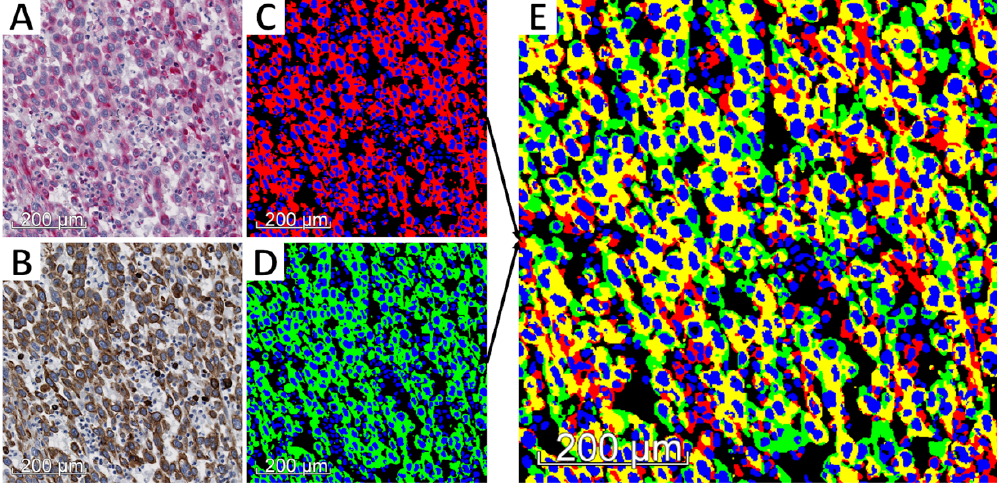
Figure 3. Steps of the hybrid E/M score computation. Registered images (from the same tissue slide) processed at 10× magnification (0.906 µm-side pixel): ( a , b ) VIM and pan-CK expression, respectively, on registered image areas; ( c , d ) detection of cell nuclei (blue), VIM+ (red) and pan-CK+ (green) areas; and ( e ) detection of pan-CK+/VIM+ area (yellow), pan-CK+/VIM − area (green), pan-CK-/VIM+ area (red). The hybrid E/M score was computed as the ratio between the yellow area and the sum of the yellow and green (i.e., pan-CK+) areas.